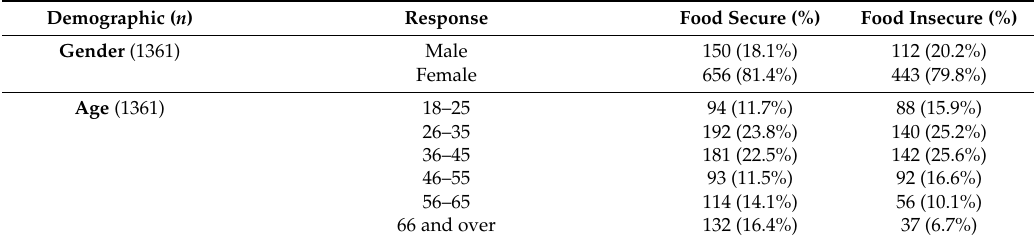
Table 2. Demographics of participants attending the Food Sensations ® for Adults program between May 2016 and April